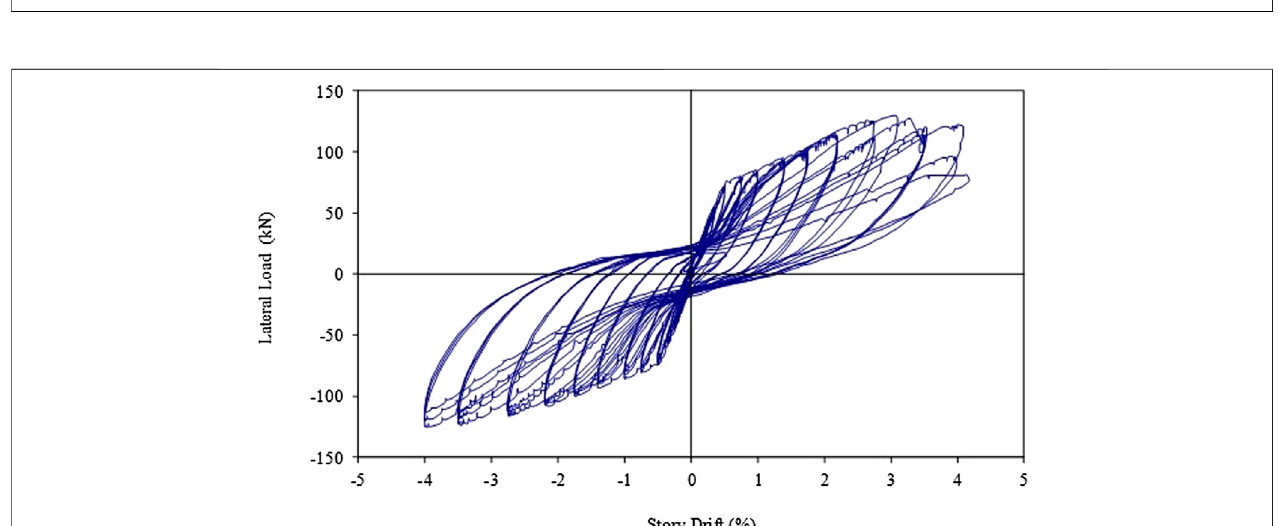
FIGURE 8 | Load — story drift response of specimen HBD_16_0.